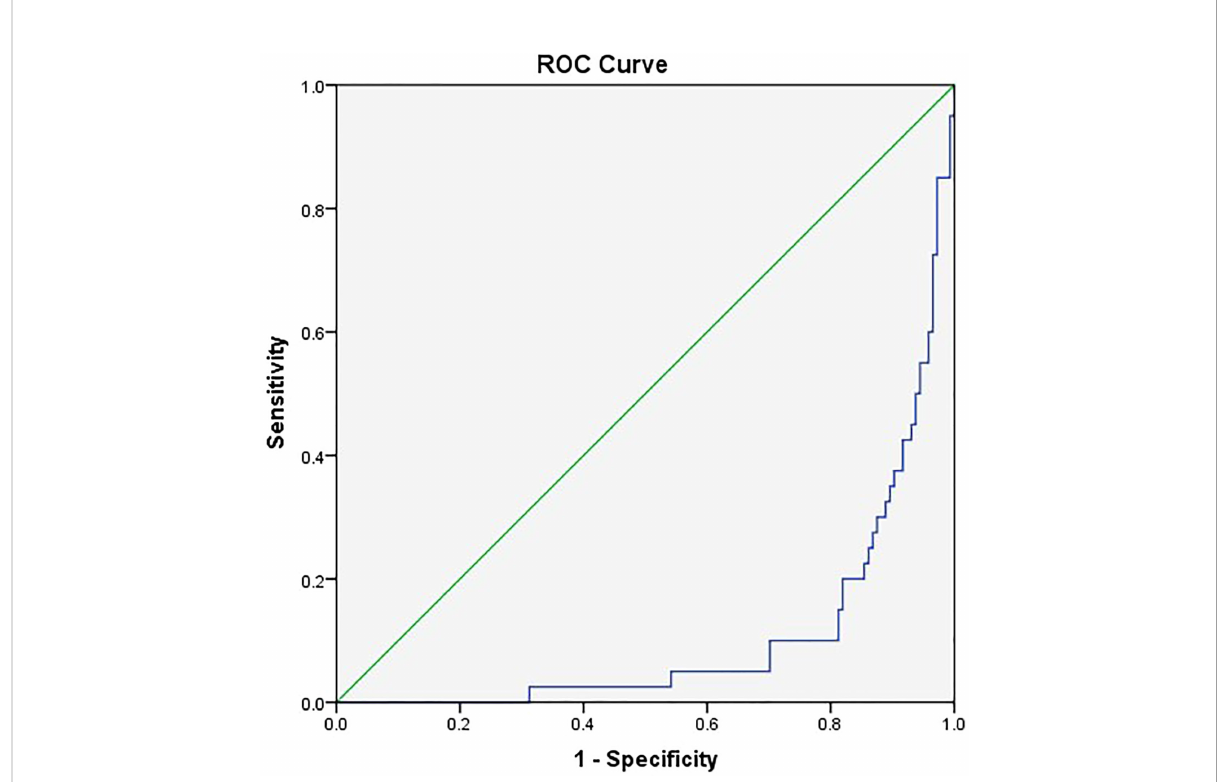
FIGURE 3 The receiver operating characteristic (ROC) curve of LCR to classify COVID-19 patients into severe and critical groups.